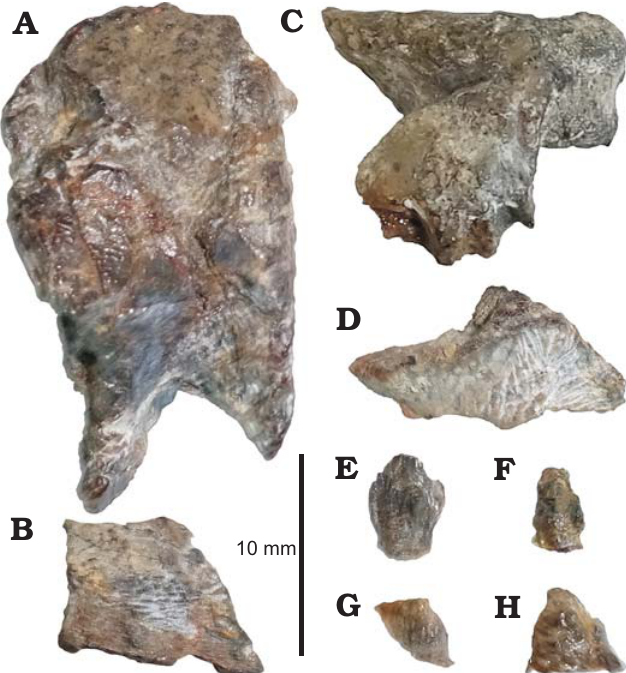
Fig. 2. Thyreophoran dinosaur Bienosaurus lufengensis Dong, 2001 (IVPP V15311, holotype), from the Hettangian–Sinemurian (Lower Jurassic), Lower Lufeng Formation of Yunnan, China. A . Possible frontal in dorsal view. B . Possible maxilla or nasal. C . Possible osteoderm, prezygapophysis or ectopterygoid. D . Possible pterygoid. E . Tooth, broken off since previous description of specimen. F . Poorly preserved tooth. G , H . Possible